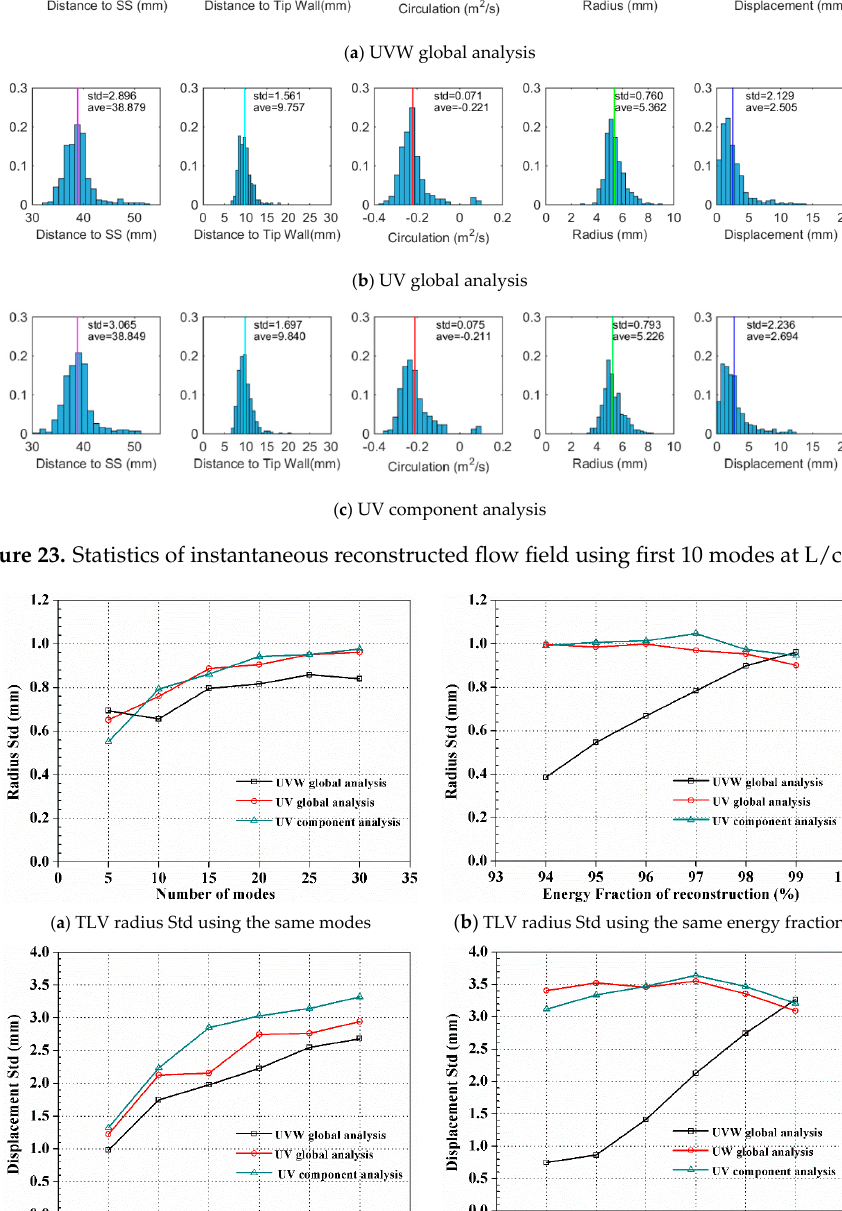
Figure 24. Comparison of reconstruction results based on the two reconstruction criteria at L/c = 1.1. The displacement is the distance of instantaneous TLV core center to the time-averaged TLV core